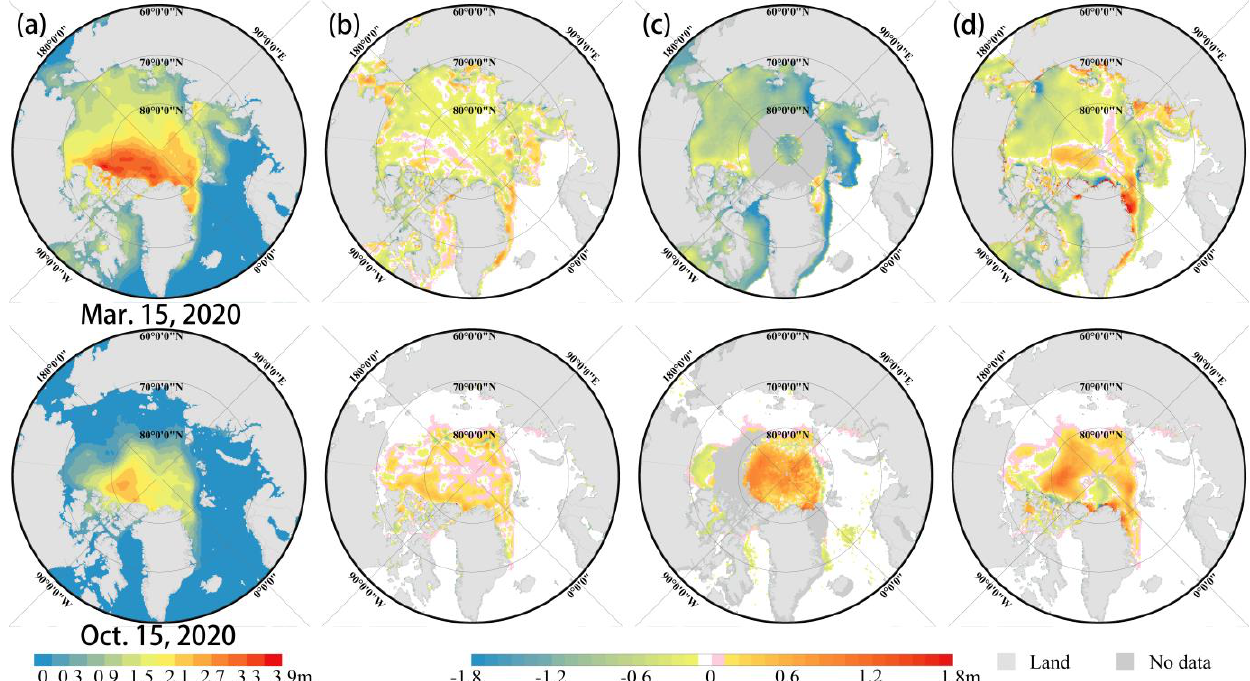
Figure 7. Daily spatial distribution of SIT from SAC-Net and difference with other SIT products. ( a ) SAC-Net thermodynamically estimated SIT maps on March 15th and 15 October 2020, with a separate color bar; ( b ) difference with CS2SMOS estimated SIT maps; ( c ) difference with APP-x estimated SIT maps; ( d ) difference with PIOMAS estimated SIT maps. The plots in columns ( b – d ) have a common color bar.